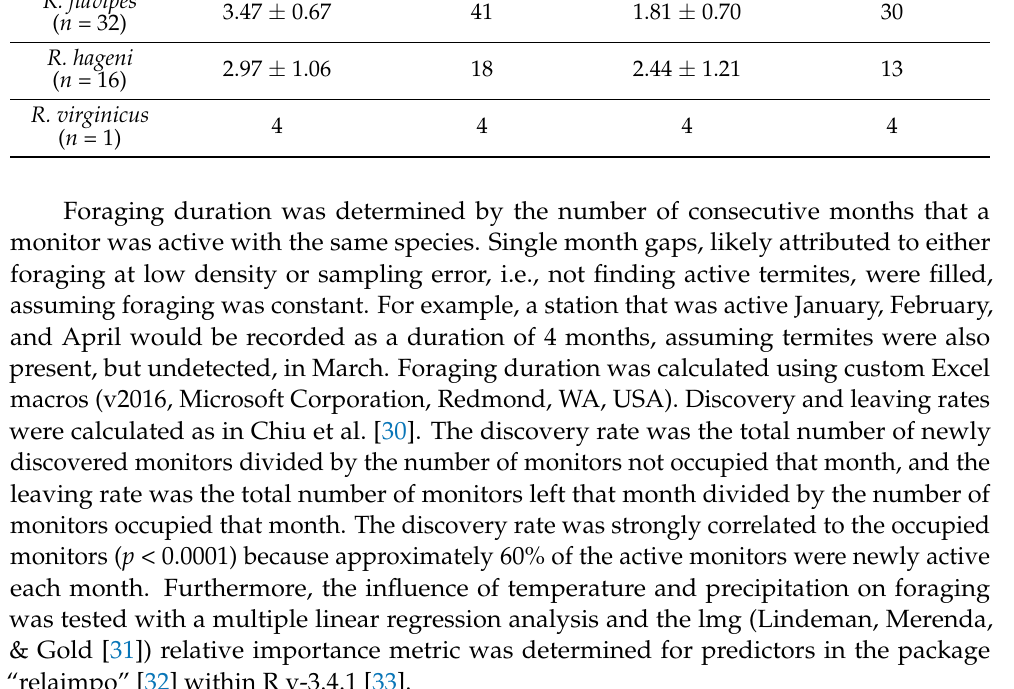
Table 1. Microsatellite allelic diversity (average ± SEM) for Reticulitermes flavipes , R. hageni , and R. virginicus in southeast Texas at two loci. Allelic Diversity Species Rf21-1 Rf24-2 ( n = Number Average Number Total Number Average Number Total Number of Colonies) of Alleles per of Alleles in of Alleles per of Alleles in Colony Population Colony Population R. flavipes ( n =